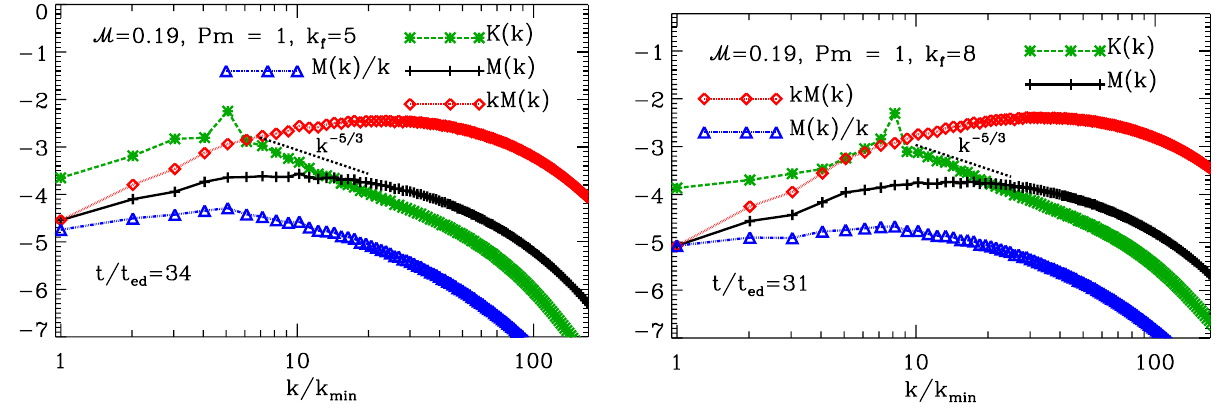
Figure 1. Power spectra of kinetic energy, K ( k ) (green dashed); magnetic energy, M ( k ) (black, solid); k M ( k ) (red, dotted); and M ( k ) / k (blue, dash-dotted) for run B (left) and run C (right). These spectra are computed from a snapshot in the saturated state for the respective runs. The black dotted line shows the k − 5/3 for comparison. Here, the wave number is normalized in units of k min = 2 π / L .